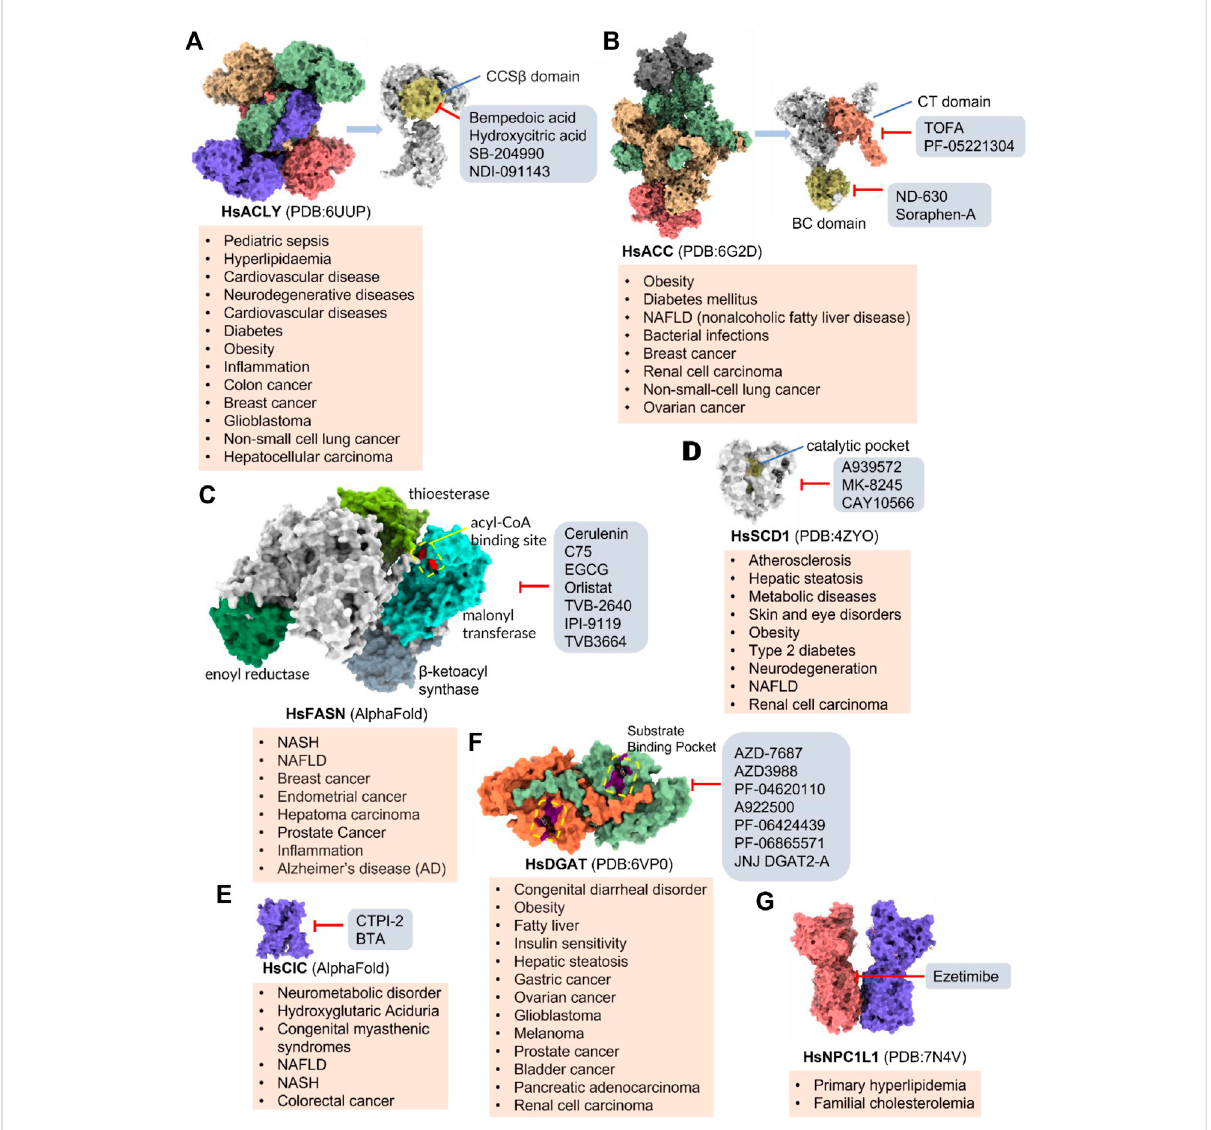
Potential pharmacological targets and related inhibitors targeting fatty acid synthesis and storage, with related diseases are listed under the respectivestructuremodel. (A) HomotetramerandsinglesubunitstructureofhumanACLY.Citryl-CoAsynthetase(CCS)modulehighlightedbydark khaki color is the region targeted by most currently known ACLY inhibitors (Bempedoic acid, Hydroxycitric acid, SB-204990, NDI-091143). (B) Human ACC fi lament structure and single subunit structure with two inhibitor targeting regions (BC domain and CT domain) highlighted. InhibitorsND-630andSoraphen-AtargettheBCdomain;TOFAandPF-05221304targetsCTdomain. (C) PredictedstructuremodelofhumanFASN (from AlphaFold database) with substrate binding site labled. Well-known small molecule inhibitors of FASN (Cerulenin, C75, EGCG, Orlistat, TVB- 2640, IPI-9119, TVB3664) are listed on the right. (D) Human SCD1 structure, with 3 inhibitor small molecules (A939572, MK-8245, CAY10566) targeting thecatalyticpocket. (E) Predicted structure model of human SLC25A1 (CIC) from AlphaFold databasewith its two famous inhibitors